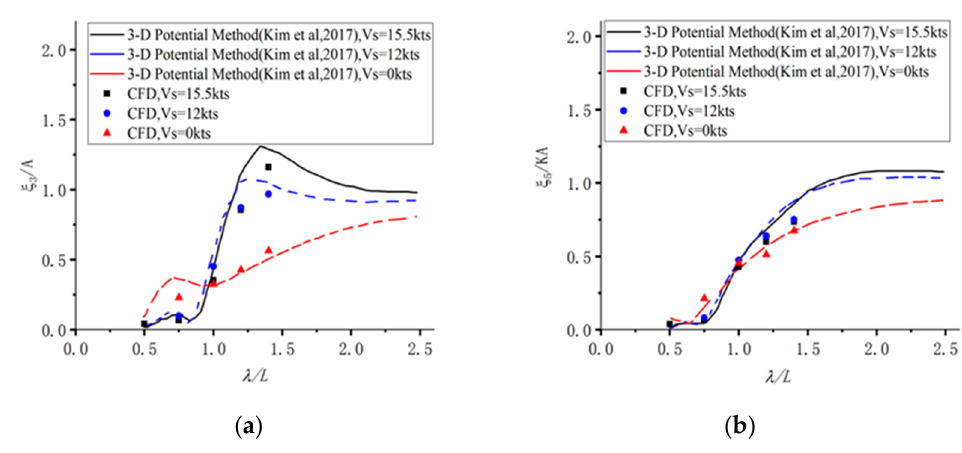
Figure 12. RAOs of KVLCC2 hull at V = 0,12,15.5 knots. ( a ) Heave; ( b ) Pitch.